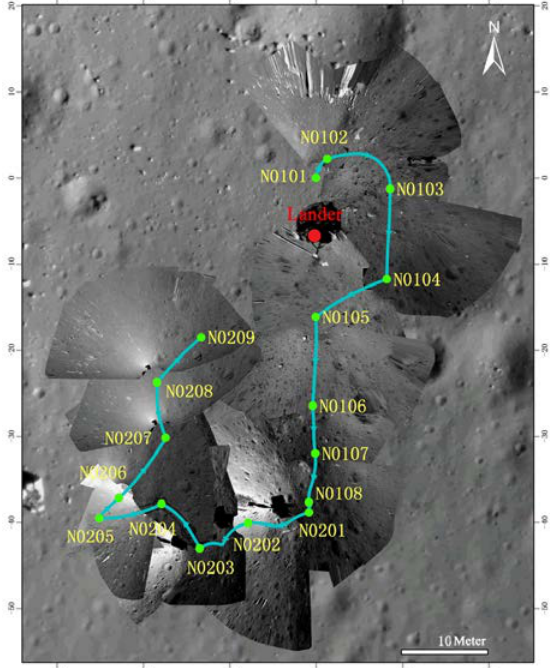
Figure 5. Overall traverse of Yutu rover as of January 16 th ,